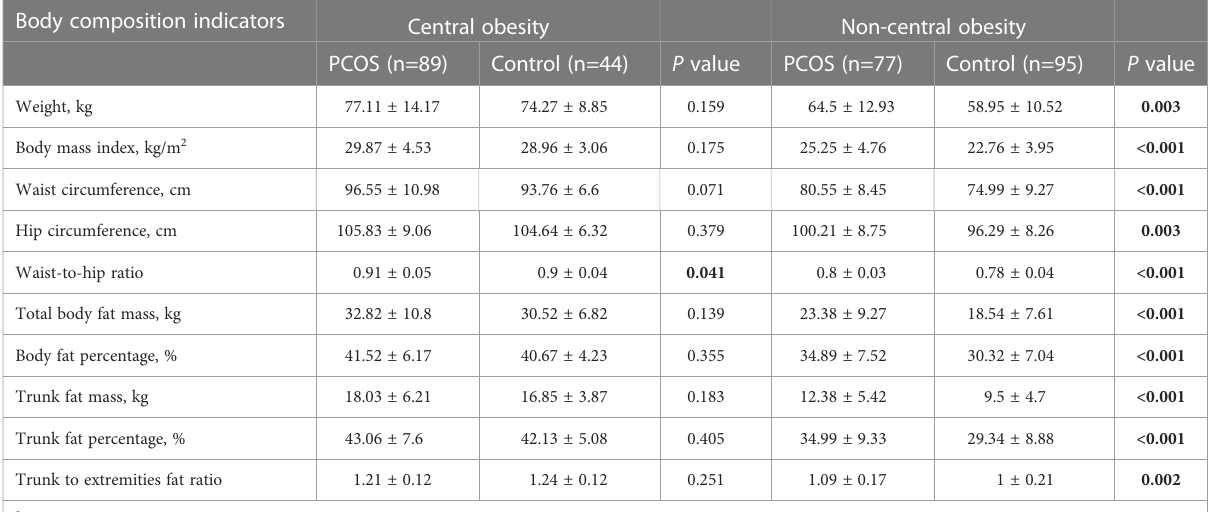
TABLE 2 Comparison of body composition indices of patients with PCOS and controls after waist-to-hip ratio strati fi cation a . Body composition